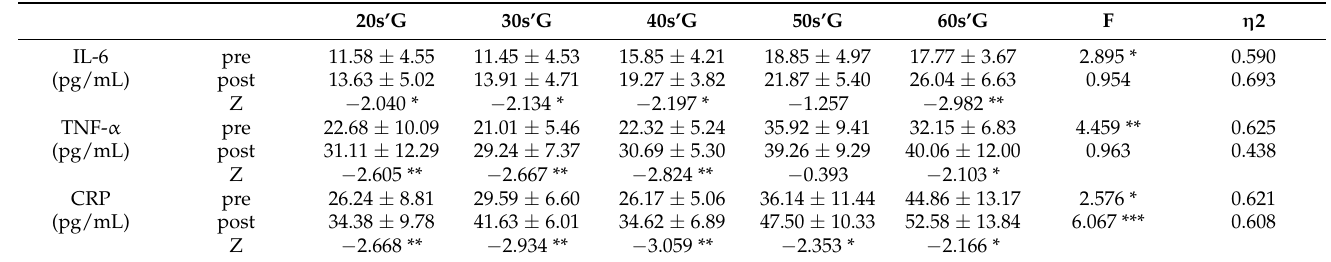
Table 5. Differences and changes in cytokines among 5 groups.